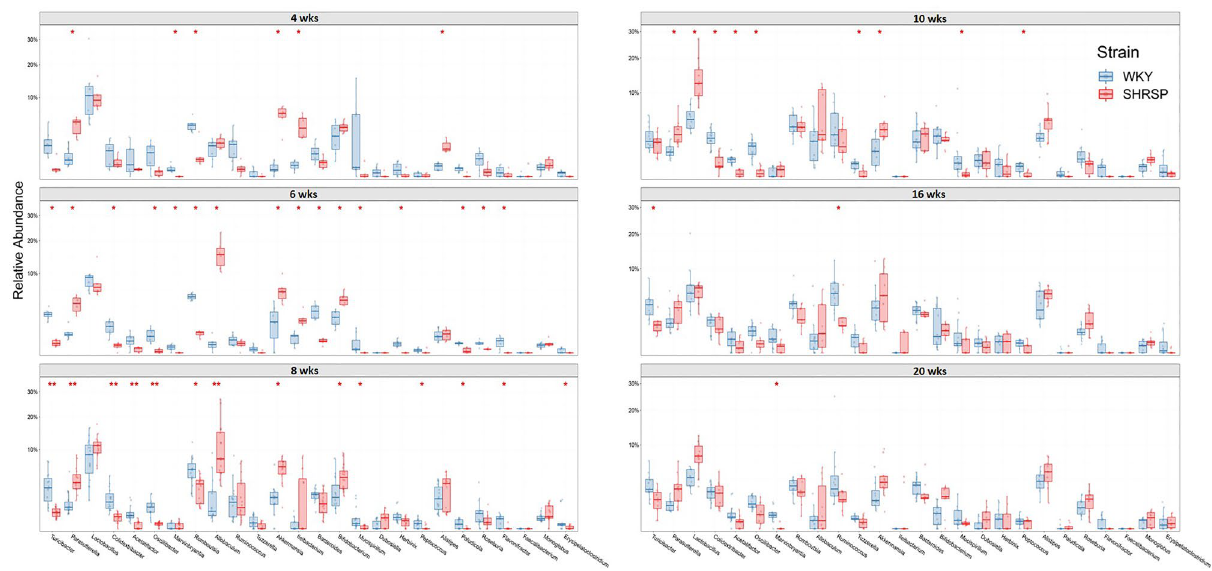
Figure 4. Relative abundance of genera in SHSRP and WKY at 4, 6, 8, 10, 16 and 20 weeks (n = 6–15). * and ** p < 0.05 and 0.01 respectively compared to WKY at the same age by Mann–Whitney U test with FDR corrected for multiple comparisons.